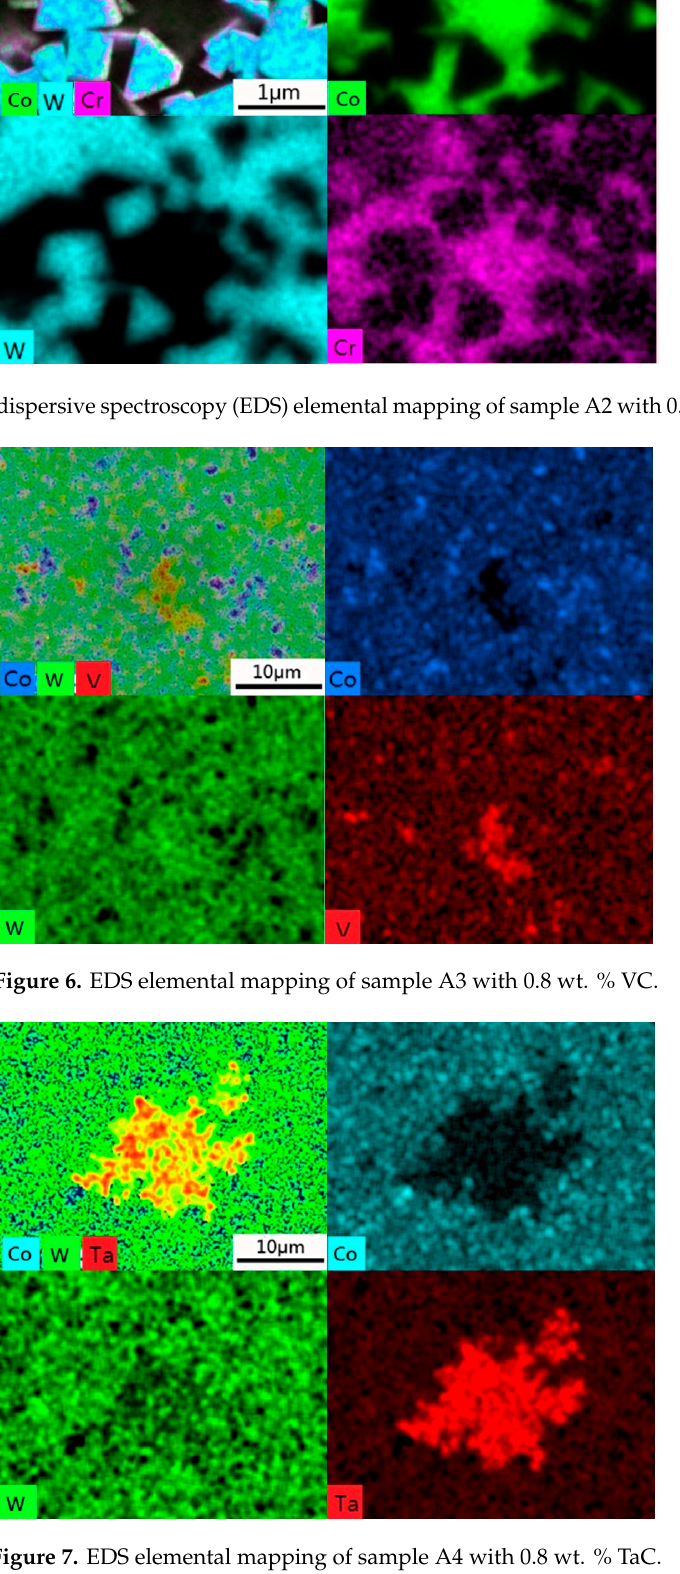
Figure 7. EDS elemental mapping of sample A4 with 0.8 wt. % TaC.